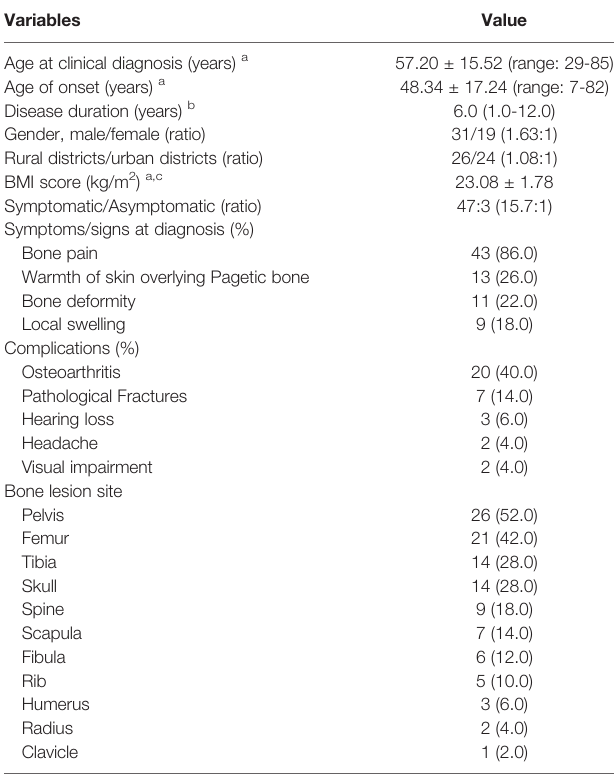
TABLE 1 | Clinical features of sporadic PDB patients in